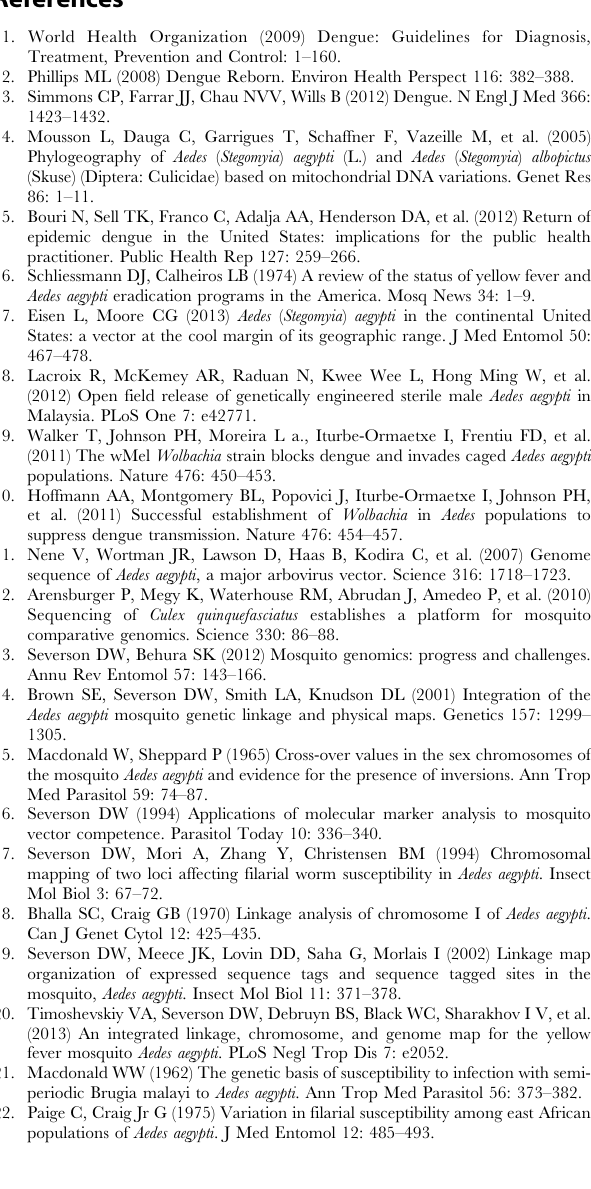
Table S4 Immunity genes that fall within the region with the maximum effect size and minimum P -value (0– 12.537 cM) on chromosome 1.